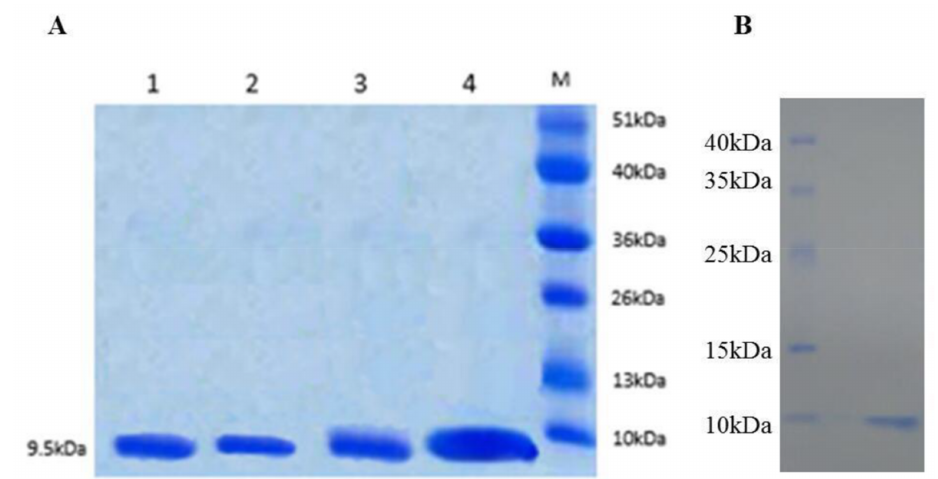
Figure 2. SDS-PAGE ( A ) and Western blot analysis ( B ) of recombinant FtTI and its mutants. ( A ) Lanes 1, 2, 3, 4, and M: recombinant FtTI mutants R65L, D67V, and R65L/D67V, recombinant FtTI , and molecular mass standards, respectively; ( B ) Western blot analysis of the purified recombinant